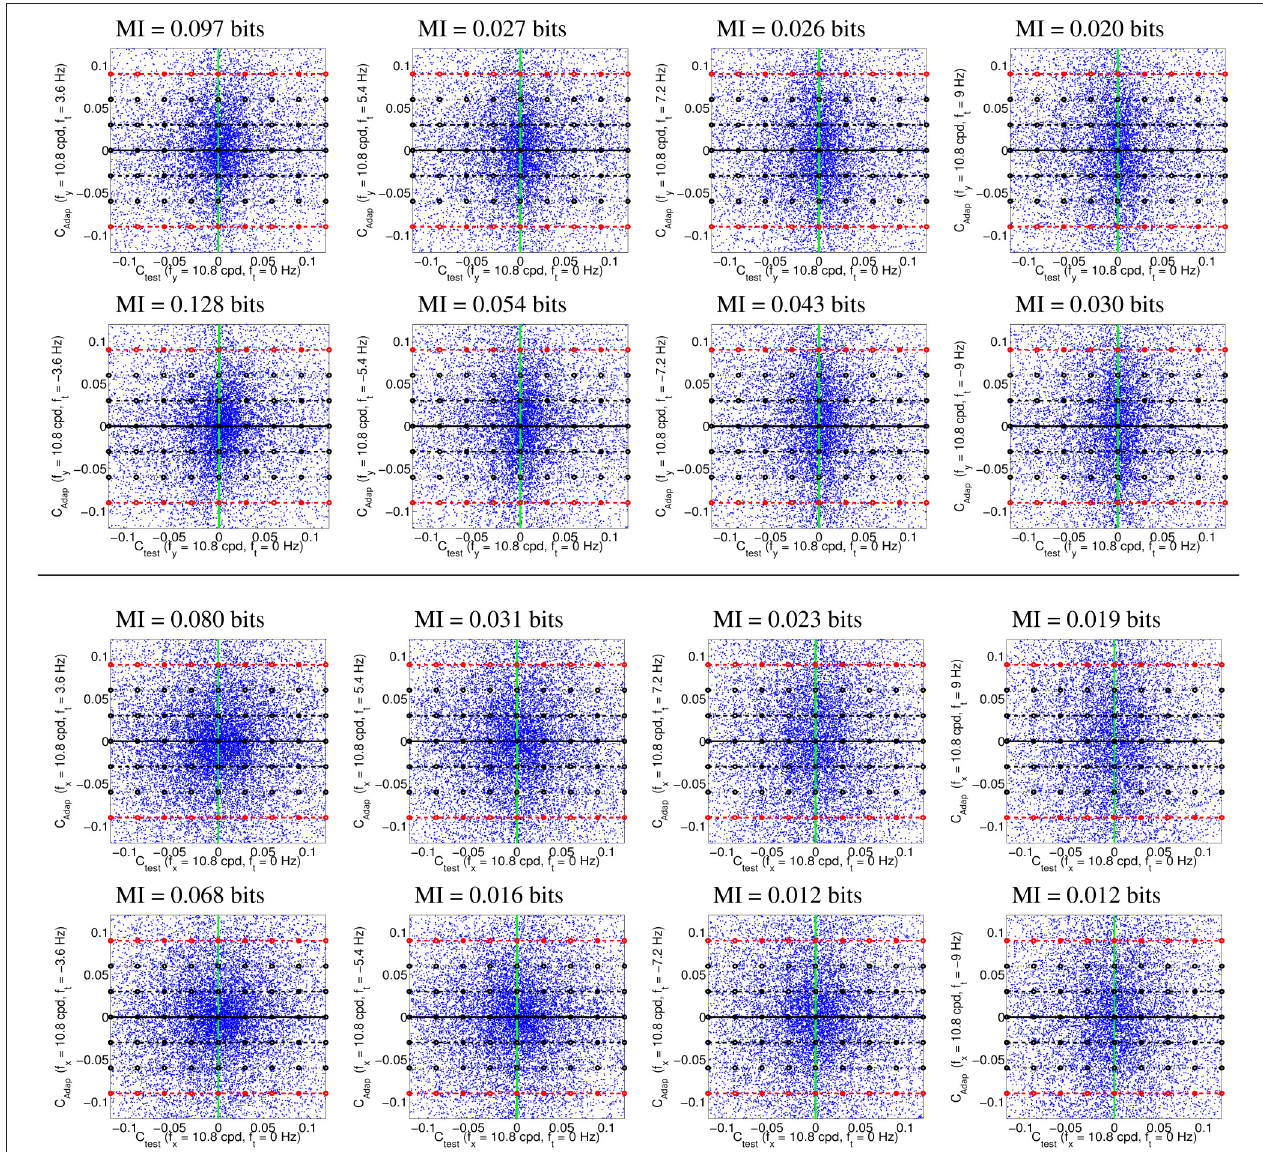
FIGURE 4 | Natural movie data after the linear stage. Scatter plot of the responses to natural sequences of V1-like linear motion filters tuned to zero speed ( C test in abscissas), and to different non-zero speeds ( C adap in ordinates). Top (1st and 2nd rows) shows relevant data for the vertical motion aftereffect: linear responses of sensors in the plane (0 , f y , f t ) . Bottom (3rd and 4th rows) shows relevant data for the horizontal motion aftereffect: linear responses of sensors in the plane ( f x , 0 , f t ) . First and second rows in each panel represent the interaction of the f t = 0 sensor with sensors of positive and negative speeds. In each row, the modulus of the speed of the considered adaptor increases from left to right: from close sensors to very distant sensors. The mutual information numbers (MI in bits) above each plot show that the relation between responses decreases as the distance in frequency increases. As in Section 1.1, the magnitude of the stimulation is expressed in contrast (amplitude over standard deviation of the